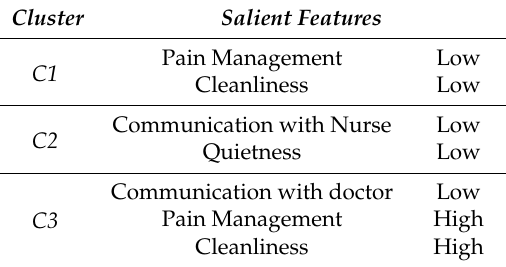
Table 7. Salient features.